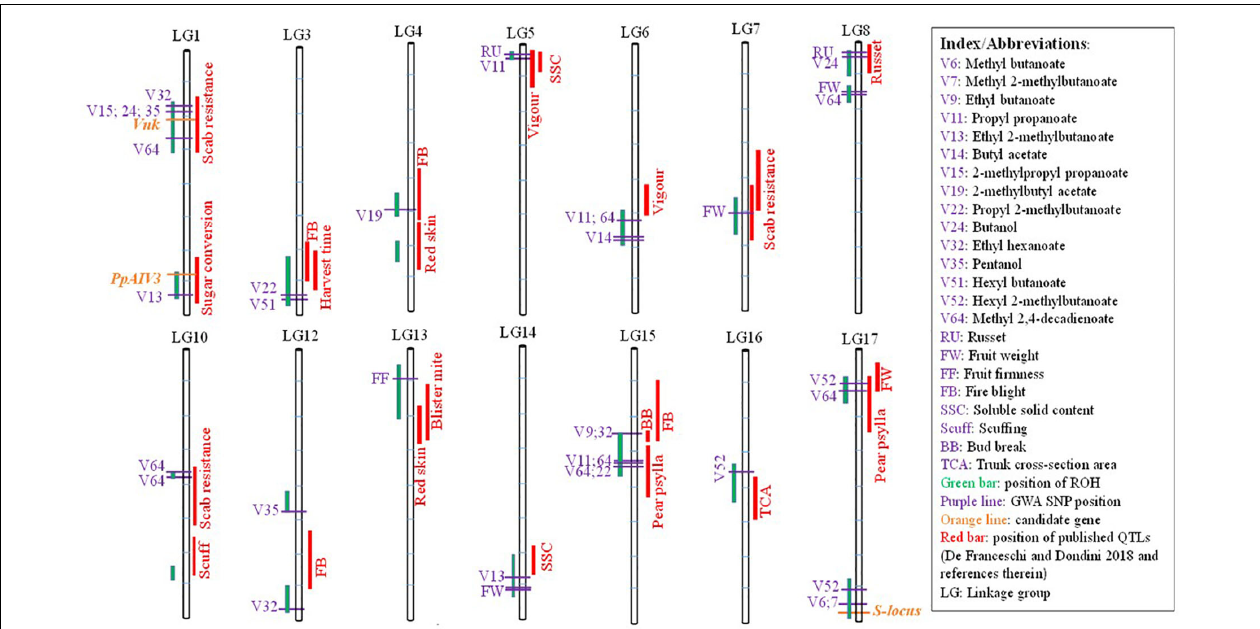
FIGURE 6 | Co-localization of runs of homozygosity islands (green bars), earlier published QTLs for various traits (red bars), marker-trait associations (purple horizontal lines) and candidates genes (orange horizontal